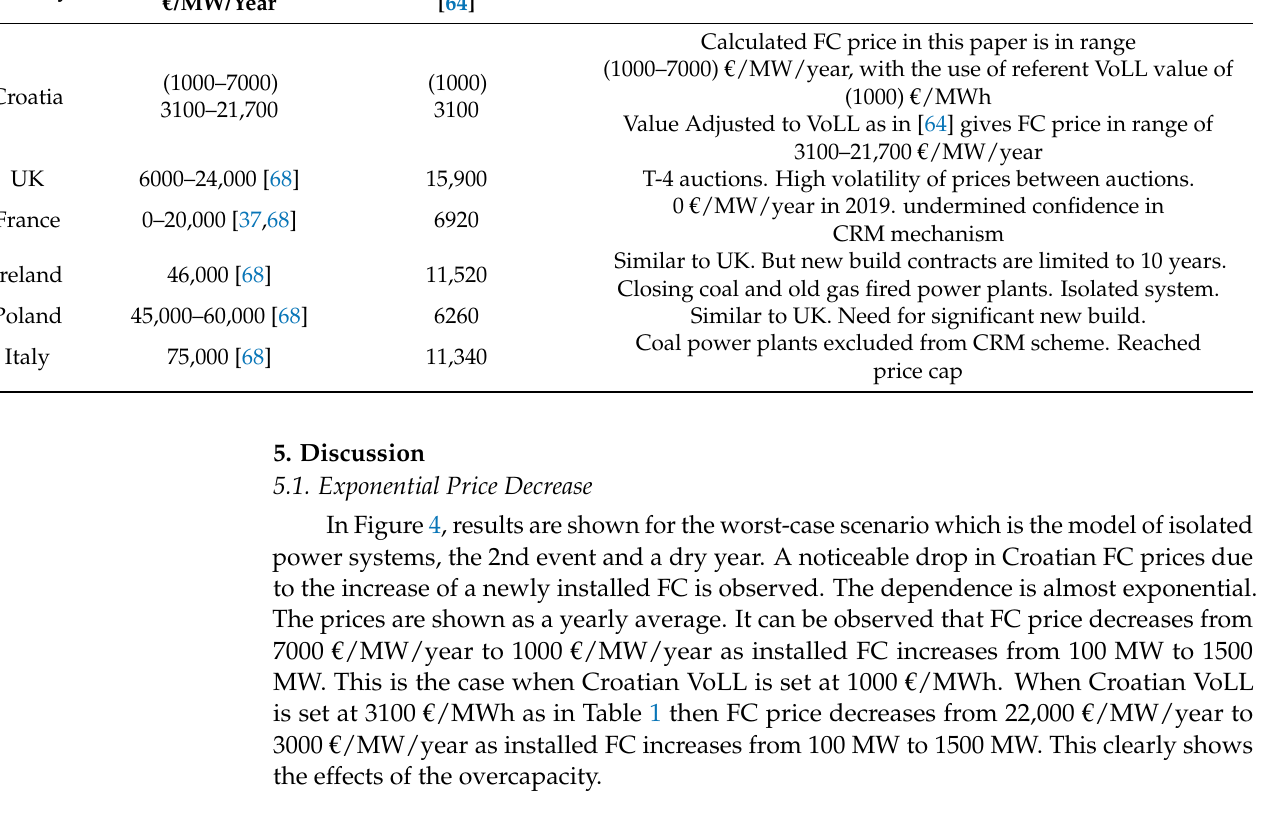
Table 1. Comparison of FC prices for different countries and capacity remuneration mechanisms (CRMs).